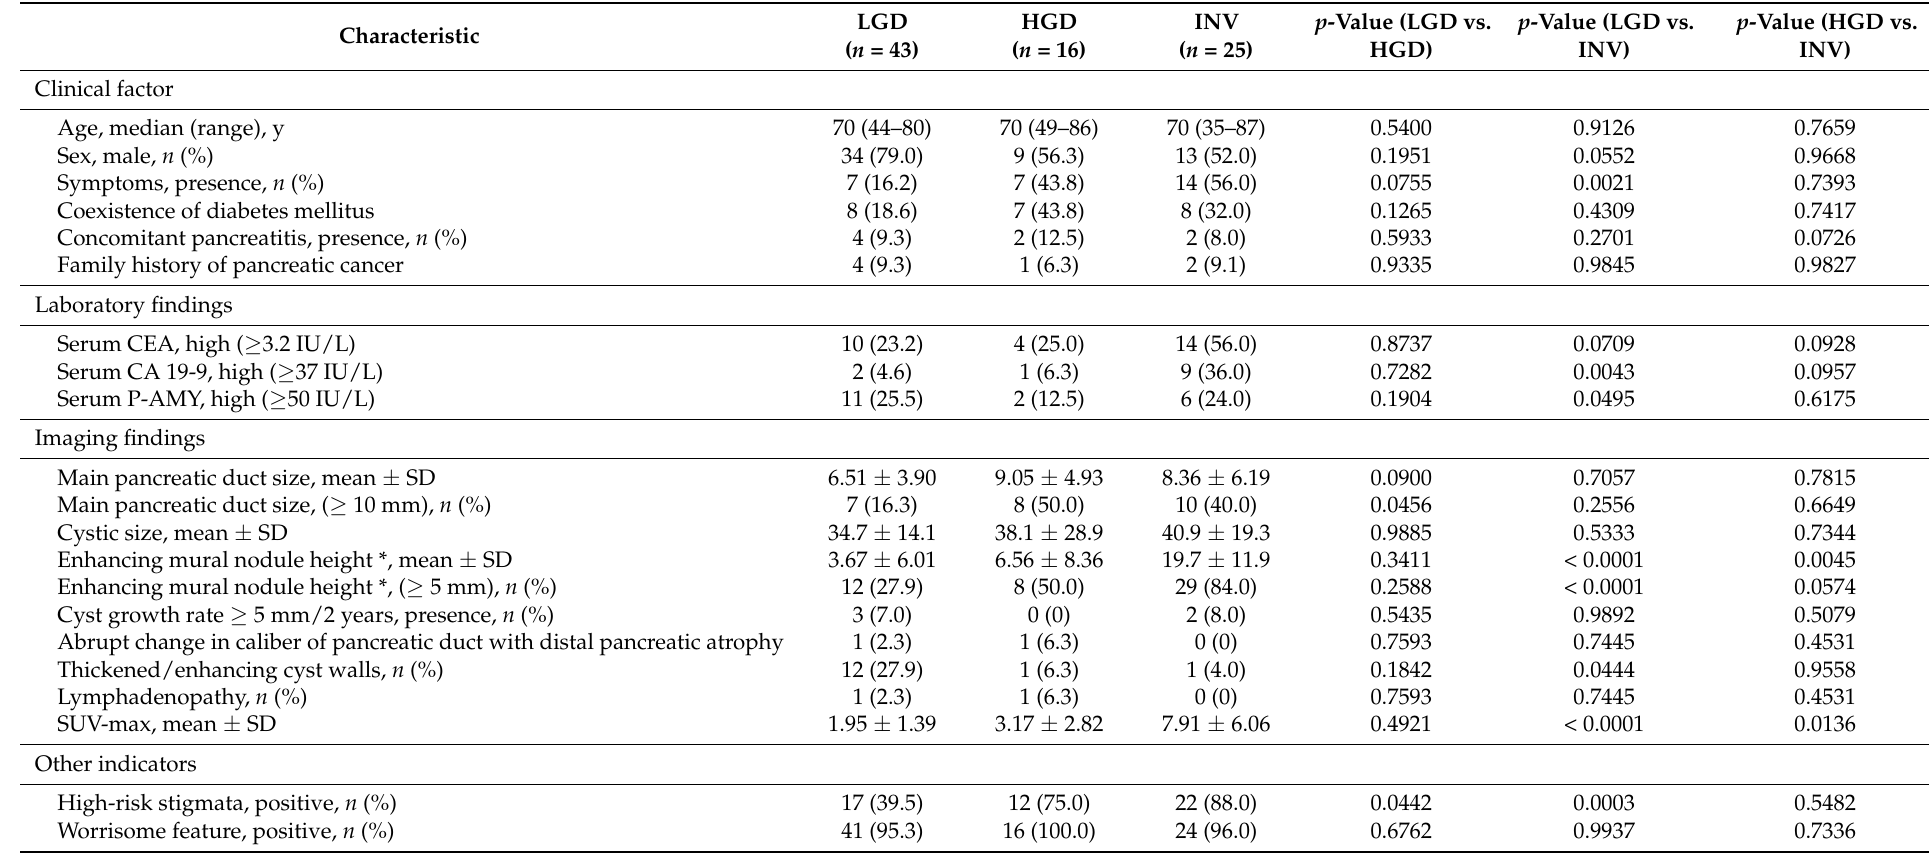
Table 3. Clinicopathological features between low-grade dysplasia, high-grade dysplasia, and invasive